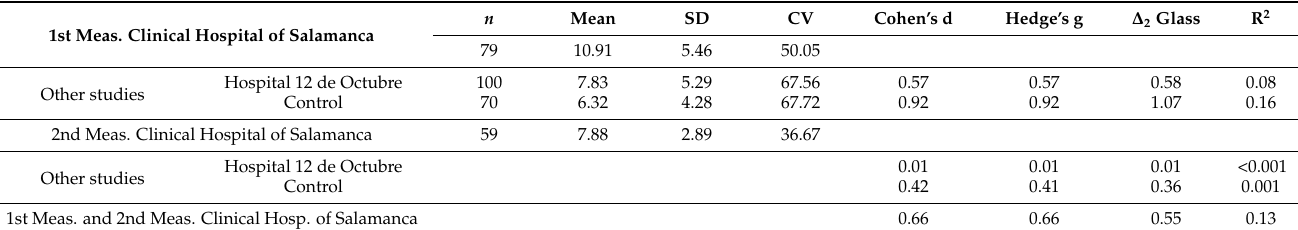
Table 4. Comparison between samples of health care professionals through effect size.